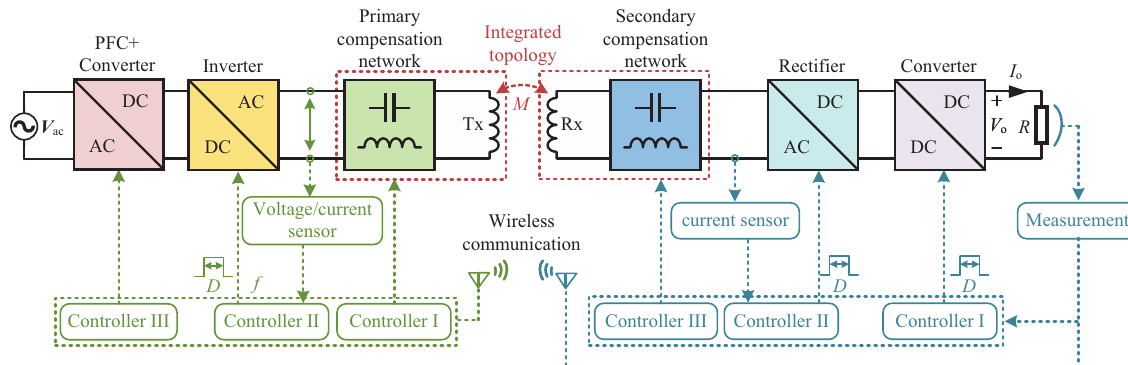
Figure 6. Schematic of possible control strategies for WPT